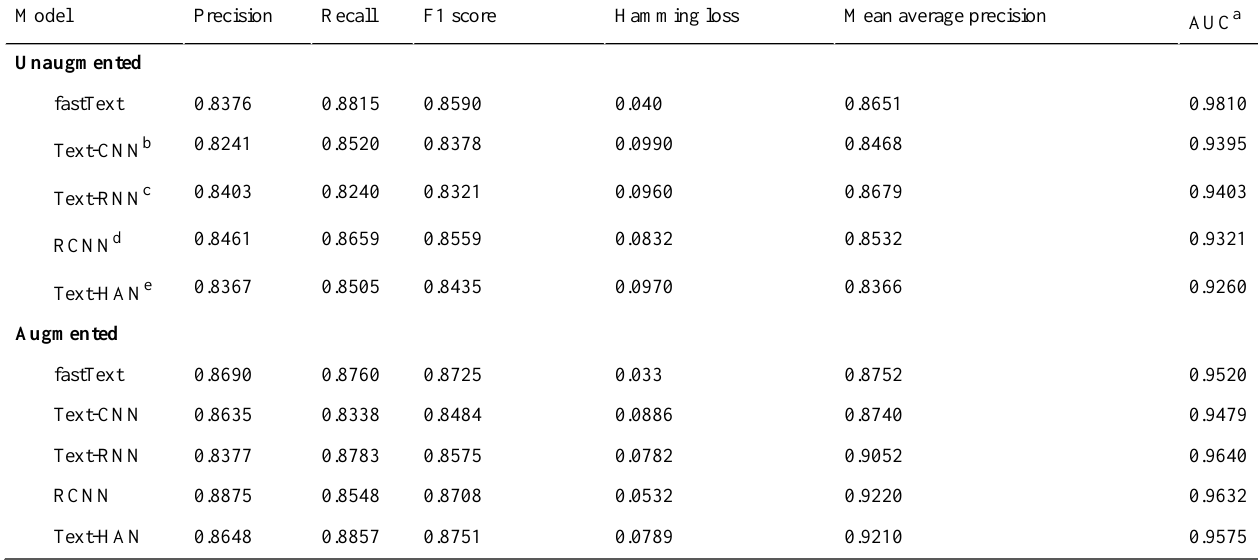
Table 3. Word encoding–based multilabel classification